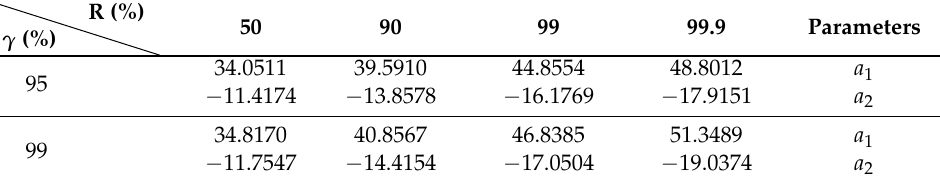
Table 6. Parameters of P-S-N curves with R a = 1.6 µ